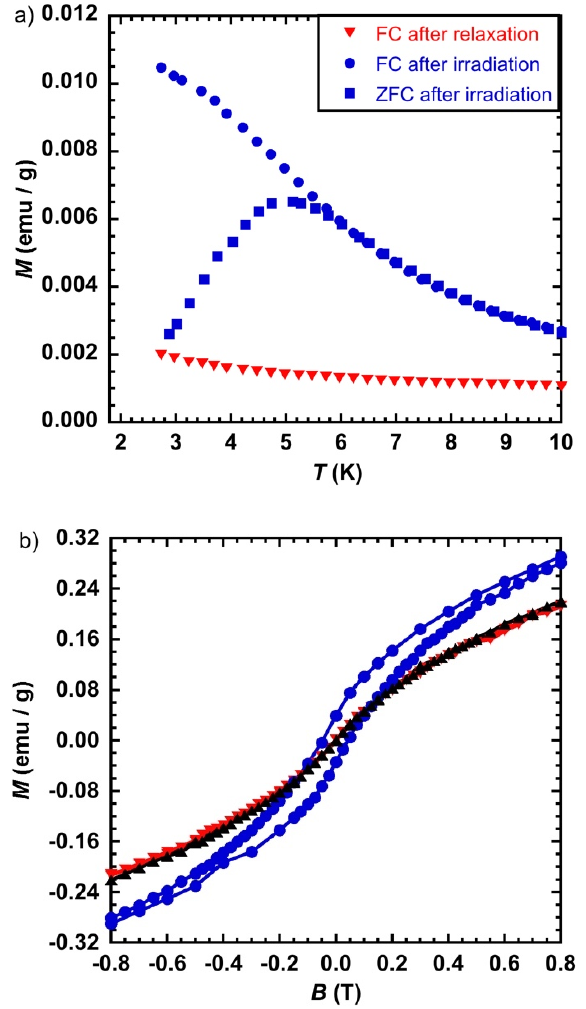
Figure 5. ( a ) M = f( T ) in the form of Field Cooled before ( (cid:72) ) and after ( • ) irradiation and Zero-Field Cooled after irradiation ( (cid:4) ), for CsCoFe_PVP and ( b ) Magnetic hysteresis loop at T = 2 K before ( (cid:72) ) and after ( • ) irradiation and after relaxation ( (cid:78) ); laser power 65 mW/cm 2 . The magnetic hysteresis loop opens after light irradiation with a coercive field of 0.053 T (Figure 5b), one order of magnitude weaker than for the non-diluted